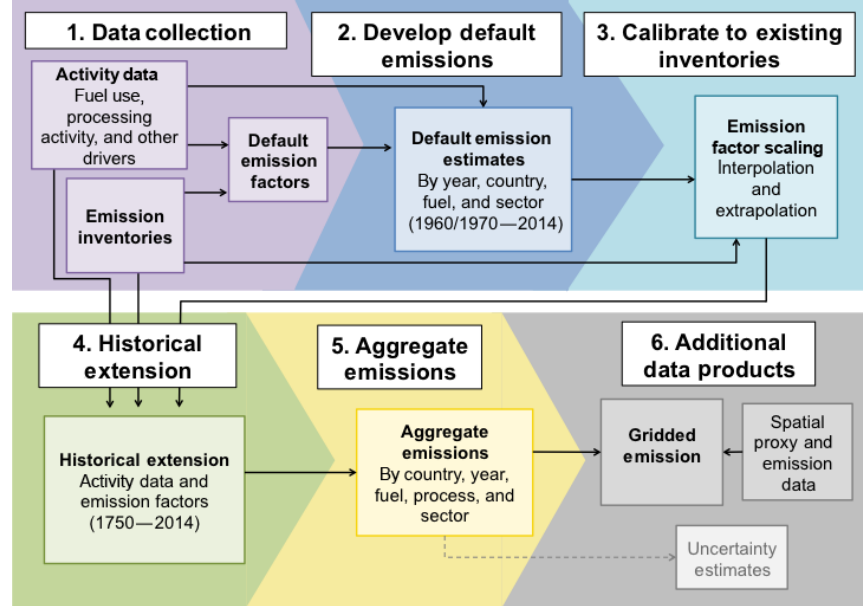
Figure 1. System summary. The key steps in calculation are to (1) collect and process activity, emission factors, and emission data; (2) develop default emission estimates; (3) calibrate default estimates to existing inventories; (4) extend present-day emission to historical time periods; (5) summarize emission outputs; and (6) produce data products including gridded emission and, in the future, uncertainty